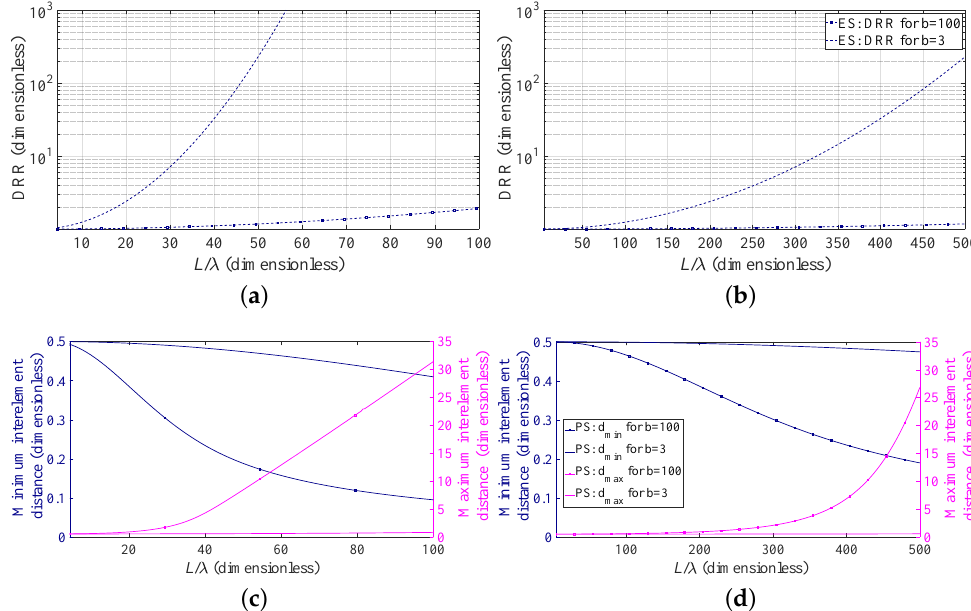
Figure 4. Dynamic range ratio (DRR) and miminum/maximum interelement distance as a function of the array aperture. Lines with markers refer to the case b = 100, and lines without markers refer to the case b = 3: ( a , c ) BW = 1 ◦ , ( b , d ) BW = 0.1 ◦